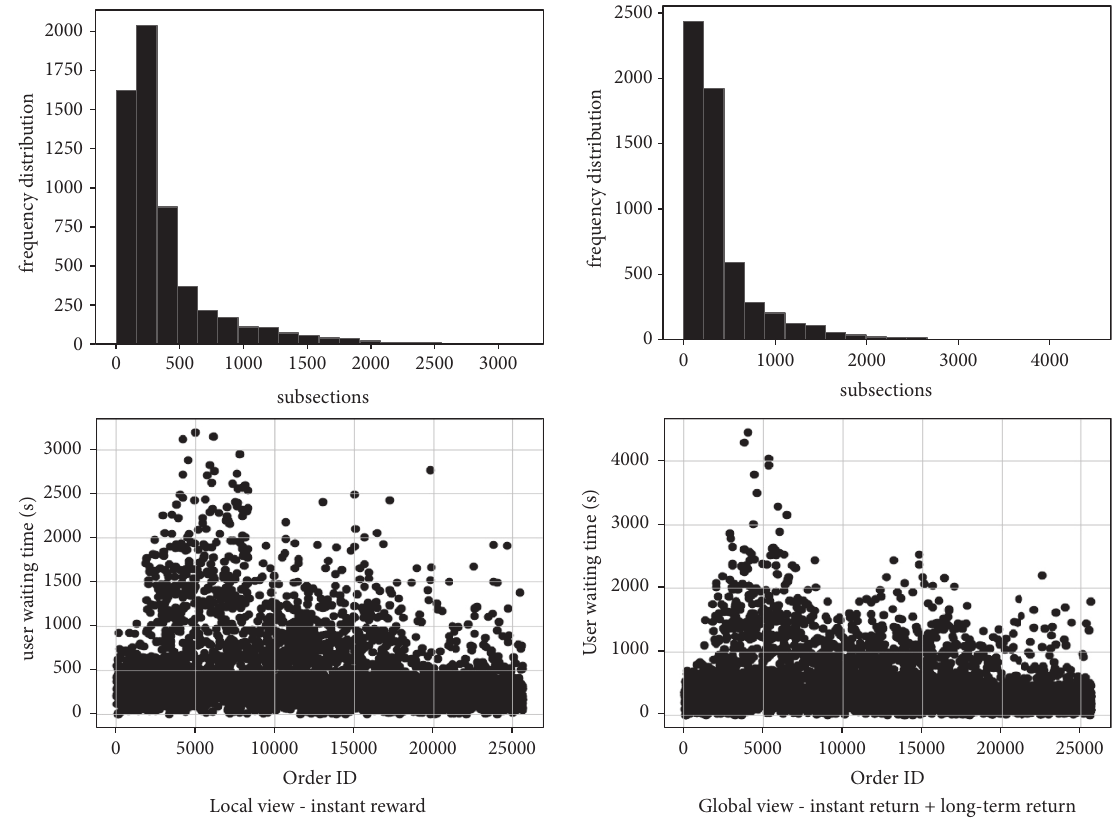
Figure 14: User waiting time comparison of global view and local